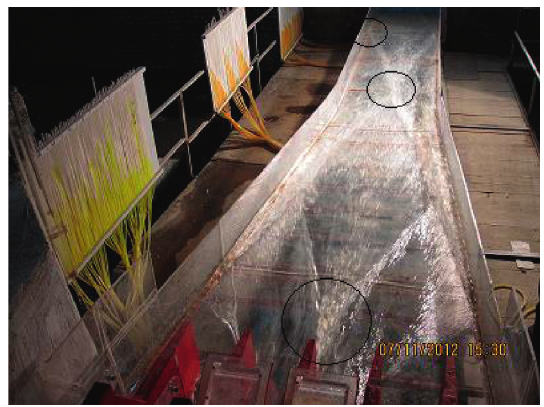
Figure 7: Flow and location of triple waves for two open middle gate